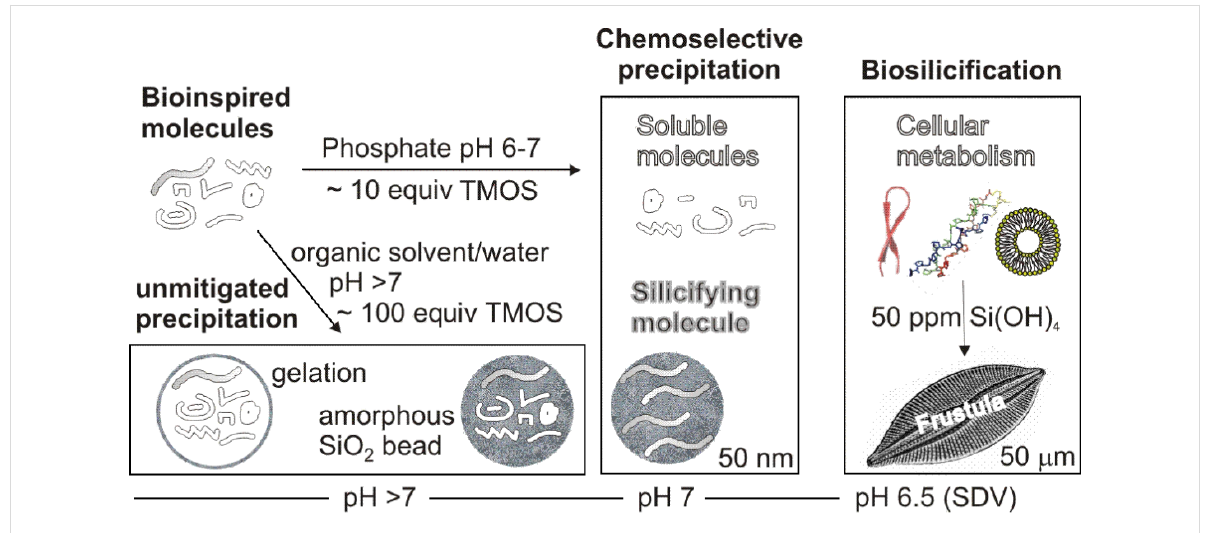
Figure 1: Chemoselective silica precipitation. Different symbols indicate a mixture of organic molecules from which only selected compounds form a precipitate with silicic acid. The remaining solution is analyzed by 1 H